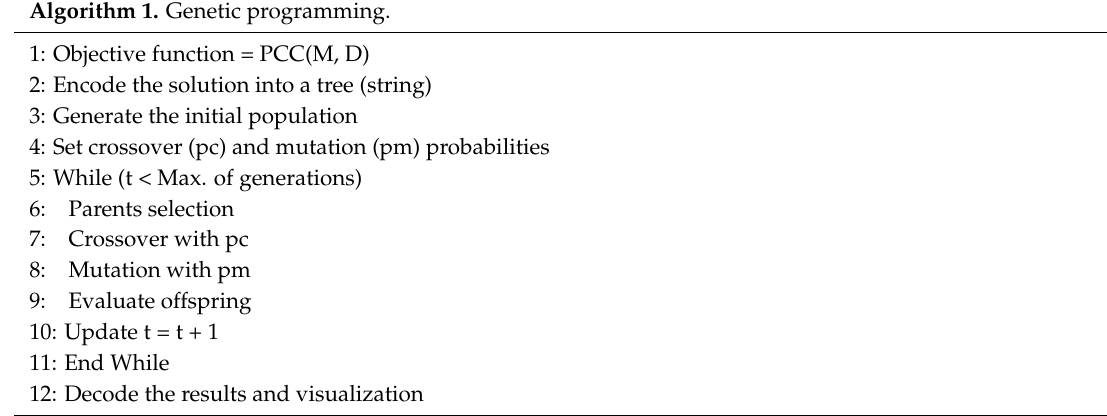
Algorithm 1. Genetic programming.